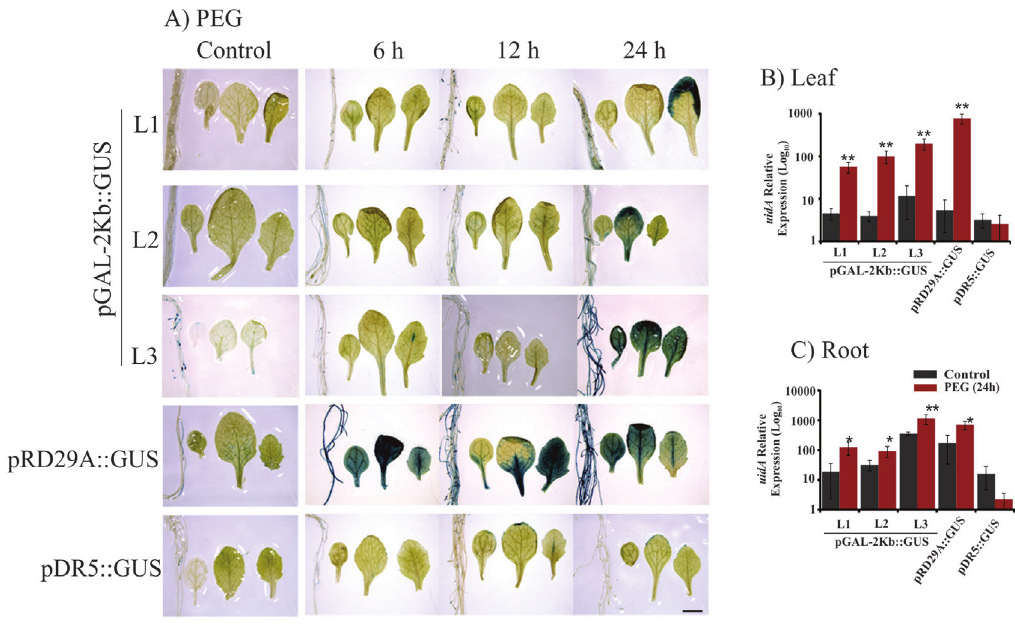
Figure 4 - Histochemical analysis and expression profile analyses of the GUS reporter gene under control of the pGAL -2kb promoter. The order of the samplephotosisasfollows:root,cotyledonalleaf,youngleafandtotallyexpandedleaf.A)Theleavesandrootsofplantsgrownundernormalconditions and PEG treatment (6, 12 and 24 h) were compared to the pRD29::GUS and pDR5::GUS plants under normal conditions and treated conditions (6, 12 and 24 h). The data shown are representative of three independent lines (n = 3). B and C) The expression levels of uidA mRNA in leaves and roots under PEG treatmentandnotreatment.Valuesaremeans (cid:5) SD(n=3).Therelativeexpressionvalues,representedonthey-axis,wereobtainedbyqPCRexperiments and calculated using the 2 - (cid:7)(cid:7) Ct method. The At4g34270 and At4g38070 genes were used as endogenous controls to normalize data. Asterisks indicate sig- nificant differences of samples under PEG treatment and no treatment (Student’s t -test * p < 0.05 and ** p < 0.01). Total RNA was extracted from the leaves and roots of three independent T3 lines of 2-week-old transgenic plants after 24 h of PEG treatment. Scale bars = 2 mm.